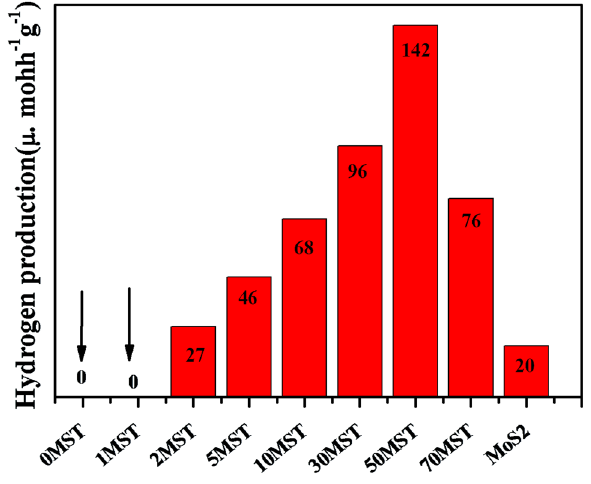
Fig. 9 Photocatalytic production of hydrogen using TiO microspheres and MoS 2 -deposited TiO 2 hollow